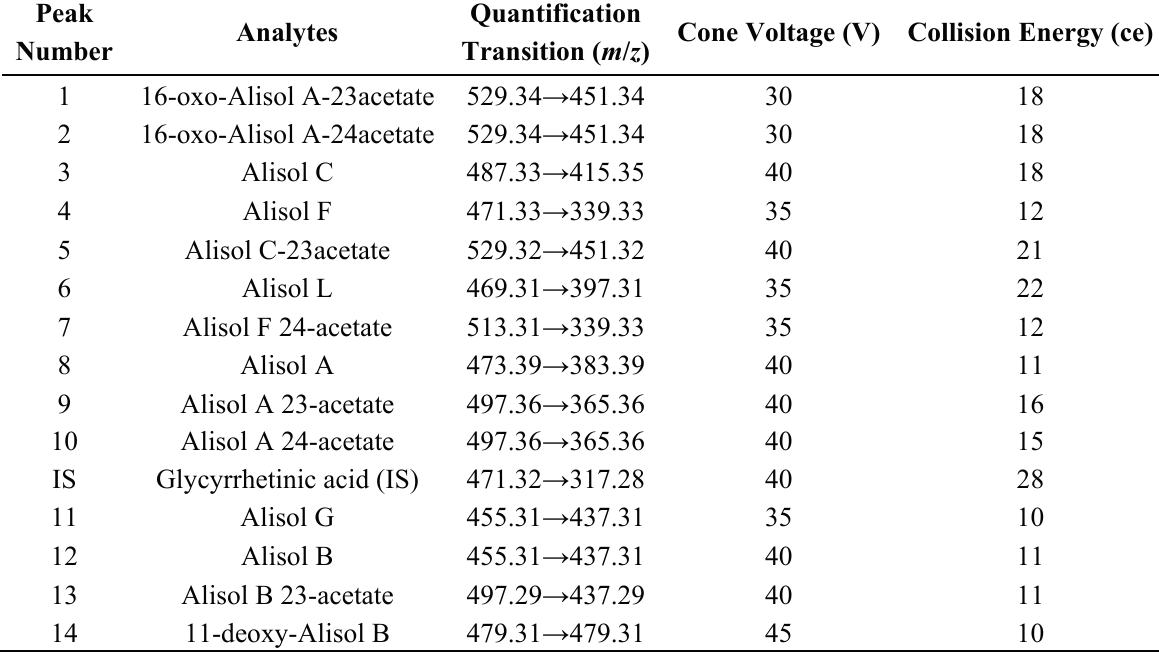
Table 1. Related MS data of fourteen investigated analytes detected on the UPLC-QqQ